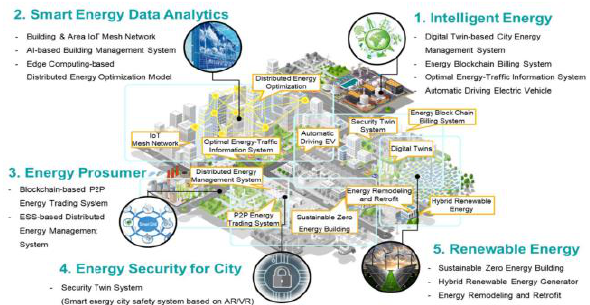
Figure 8: Future model for sustainable smart energy city (Sanguk et al.